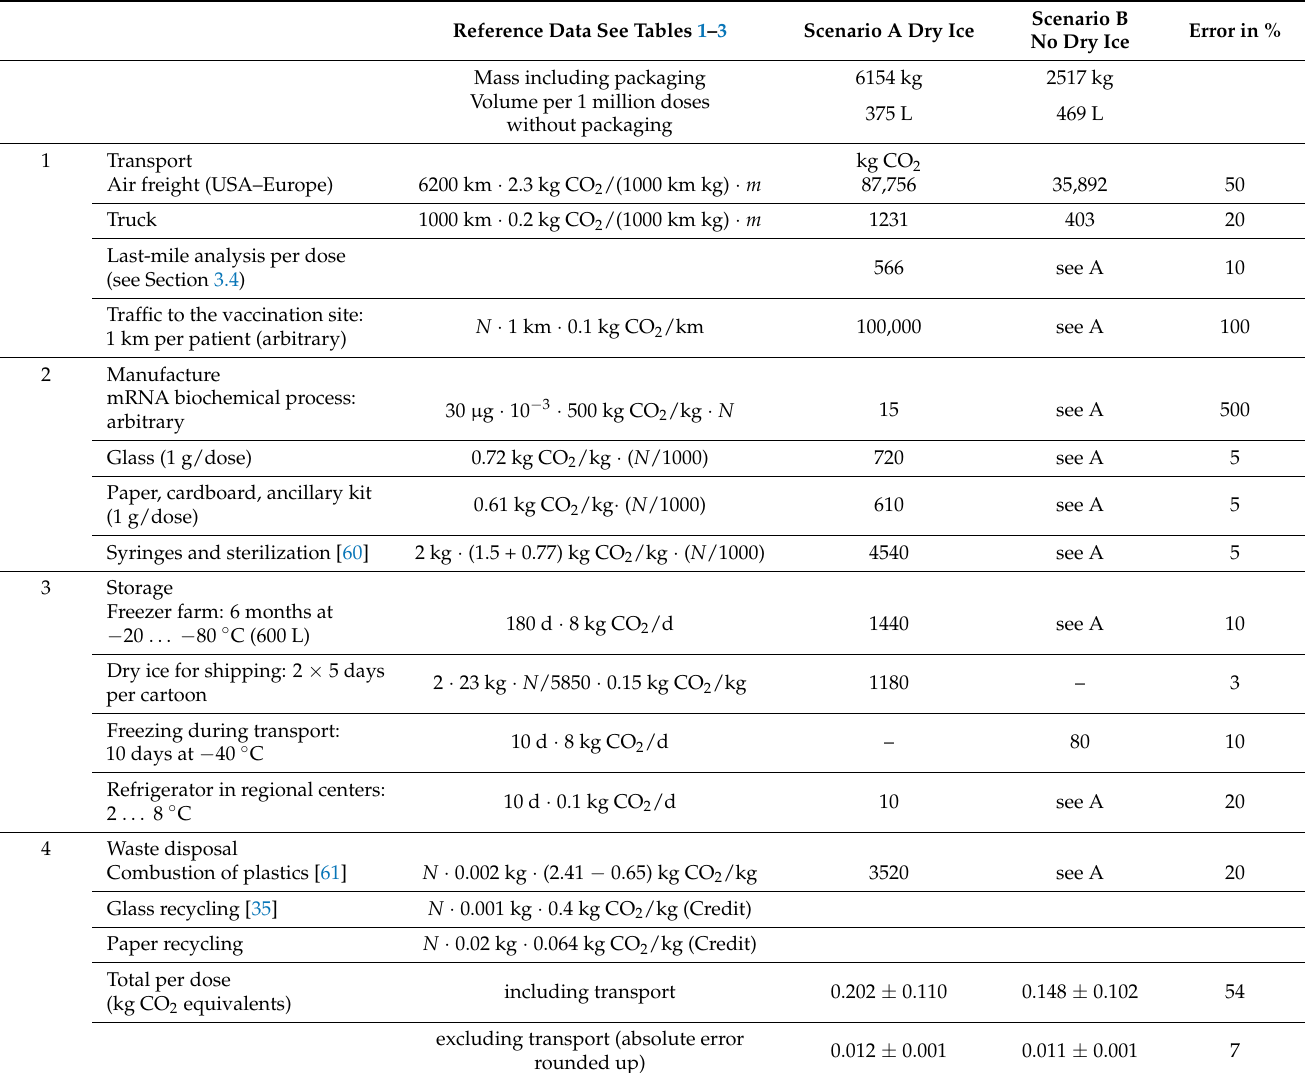
Table 5. Attempted estimation: CO 2 equivalents for transportation and storage of N = 1 million doses of mRNA